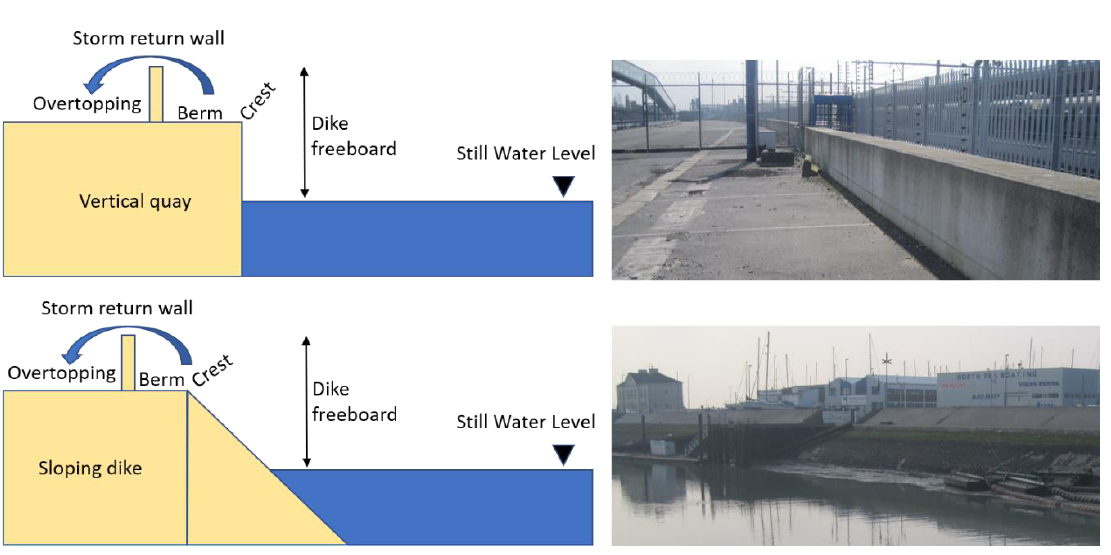
Figure 1. Model set-up based on the real cases from Belgian harbors. Upper part: vertical quay design and an example of storm return wall at Ostend harbor. Lower part: sloping dike design and an example at Blankenberge harbor.